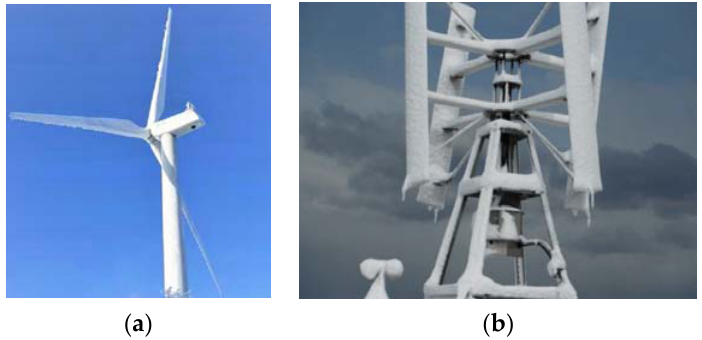
Figure 1. Icing on wind turbines. ( a ) Icing on a HAWT; ( b ) icing on a VAWT.